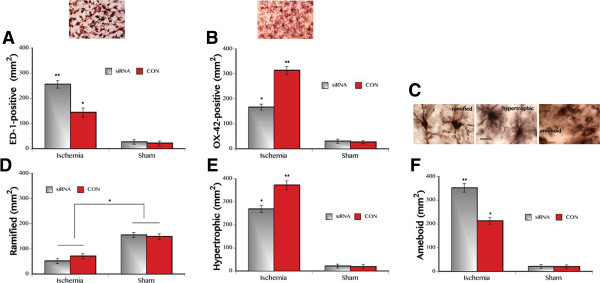
Cerebral ischemia and CX3CR1 deficiency increased microglial activation in the hippocampus. (A) Significantly increased phagocytic microglia was detected in ischemic rats with CX3CR1 deficiency in comparison to the sham rats and the ischemic control animals. Expression of phagocytic microglia was also significantly increased in the ischemic control rats in relation to the sham group with the greatest increased seen in the CX3CR1 deficient rats. In contrast, the number of ED1-positive cells in the sham rats was negligible and no group difference was seen. Upper panel shows representative photomicrograph of ED1 staining showing larger cell bodies and very short processes. (B) Significantly increased OX-42 microglia phenotype was detected in ischemic control rats compared to the ischemic animals with CX3CR1 deficiency and sham groups. OX-42-positive cells were also significantly increased in ischemic animals with CX3CR1 deficiency in comparison to the sham groups. The number of OX-42-positive cells in the sham rats was negligible and no group difference was seen. Upper panel shows representative photomicrograph of OX-42 staining showing large cell bodies and short processes. (C) Representative photomicrographs of the different microglial phenotype. Ramified microglia or ‘resting microglia’ have smaller cell bodies and longer processes while hypertrophic microglia, also considered as moderately activated, shows bushy appearance, larger cell bodies, and shorter processes. Meanwhile, the ameboid phenotype, considered as highly activated, shows large cells bodies with almost no processes evident. Scale bar = 100 μm. (D) When microglial phenotype was quantified, the ‘resting’ form was significantly increased in the sham groups compared to the ischemic animals but microglial activation was seen in both ischemic groups. The hypertrophic phenotype (E) was significantly increased in the ischemia control rats while expression of the (F) ameboid phenotype was significantly higher in the ischemic animals with CX3CR1 deficiency. The number of hypertrophic and ameboid microglial phenotype in the sham groups were negligible. *P <0.05 and **P <0.01.